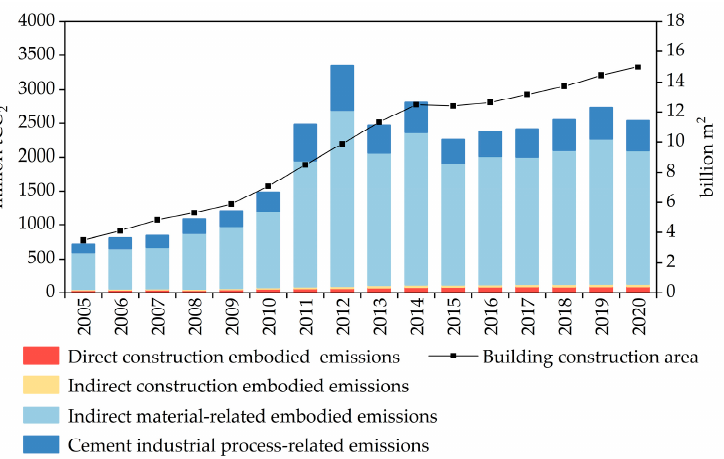
Figure 11. Total annual embodied carbon emissions of China’s building sector measured by the P-LCA accounting model (2005–2020).